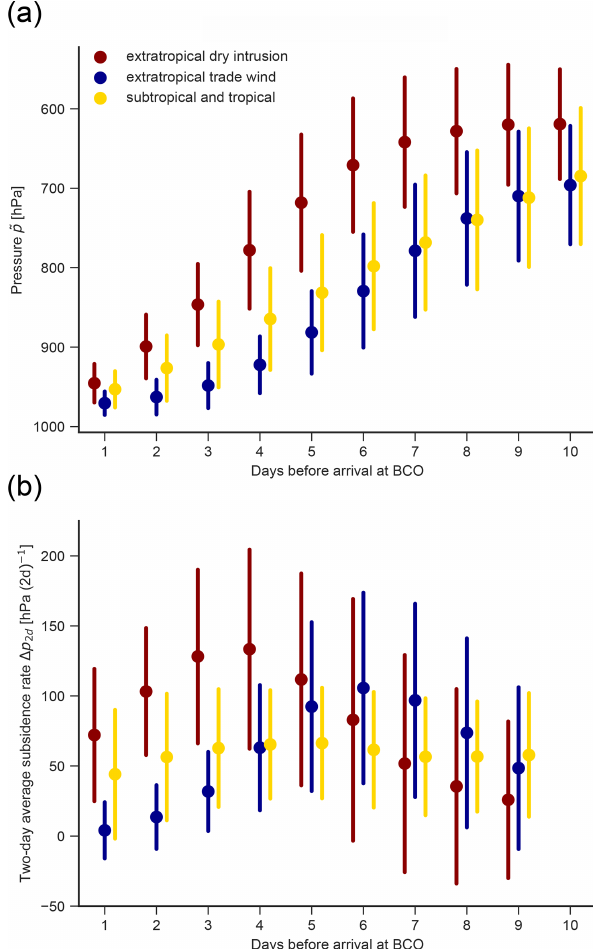
Figure 4. Climatological mean and standard deviation (bar) show- ing the pressure (a) and 2d (centred) subsidence rate (b) of the 40 sub-cloud layer air parcels within 1 to 10d prior to their ar- rival above Barbados in January–February 2009–2018, classified into regimes with different transport pathways. The extratropical dry intrusion regime (27% occurrence frequency) is shown in dark red, the extratropical trade wind regime (28%) in blue and the trop- ical regime (44%) in